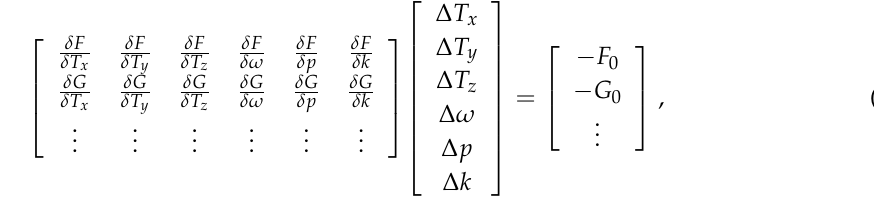
Figure 9. Top: before optimization (top image). Bottom: after optimization (sequence 03; frame 233).